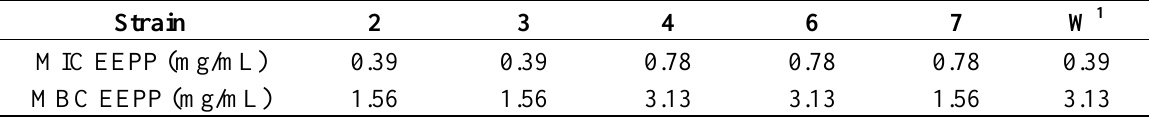
Table 2. Susceptibility of S. aureus MSSA strains to EEPP (MIC and MBC values in mg/mL). Strain